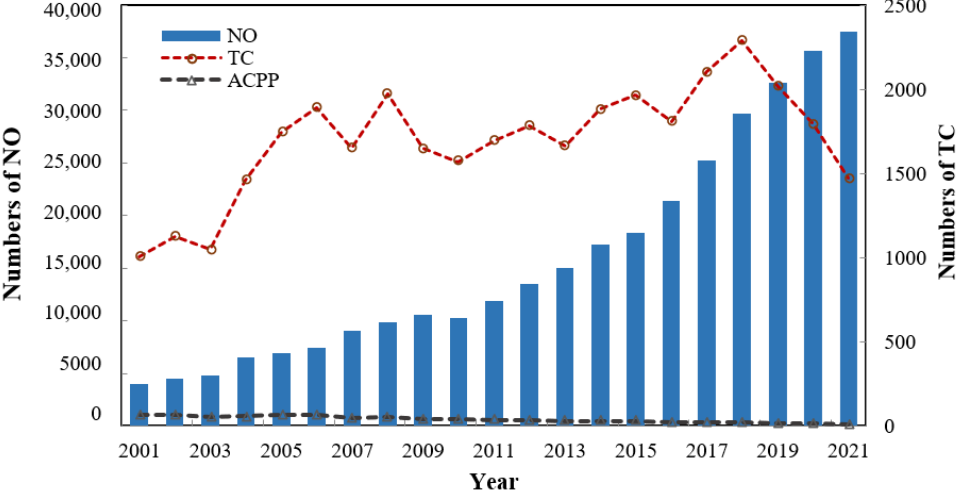
Figure 2. Numbers of the NO, TC, and ACPP during the period of 2001–2021. Notes: NO represents the number of published articles, TC represents the total citations of articles, and ACPP represents the average citation counts of each article.